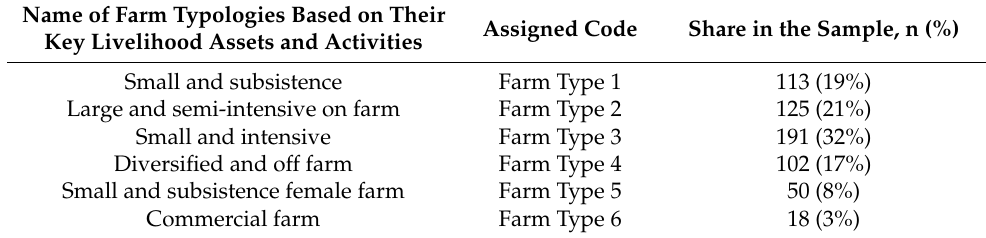
Table 4. Name of farm types and their share in the sample.